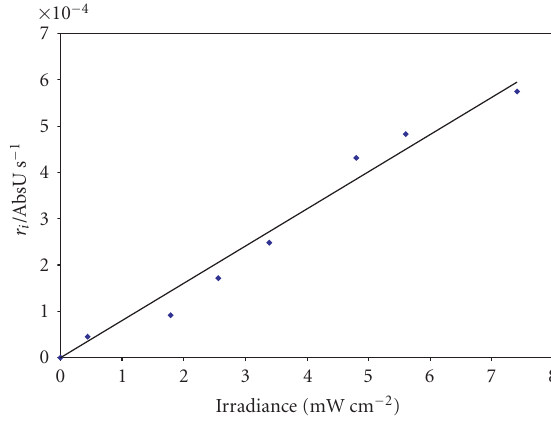
Figure 5: The variation in r i ( ) and the λ max ( ◦ ) as the level of glycerol in the ink formulation is altered between 0 and 0.1g.